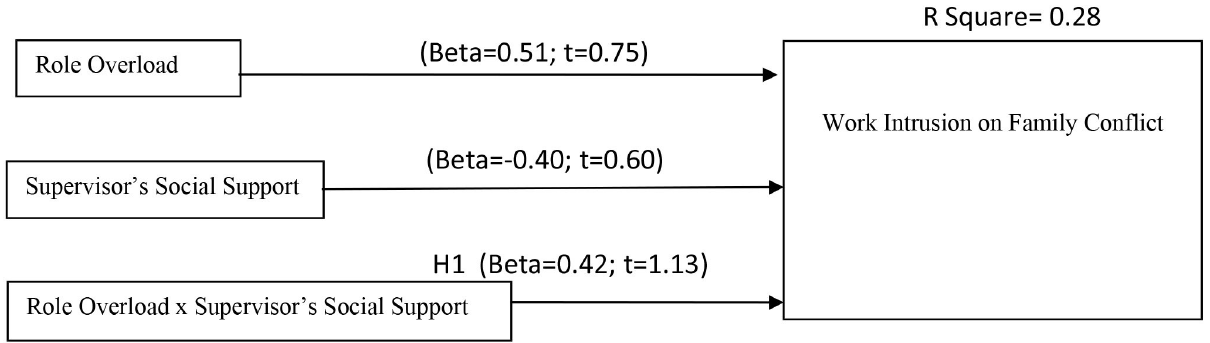
Figure 4. The Results of SmartPLS Path Model Showing the Moderating Effect of Supervisor’s